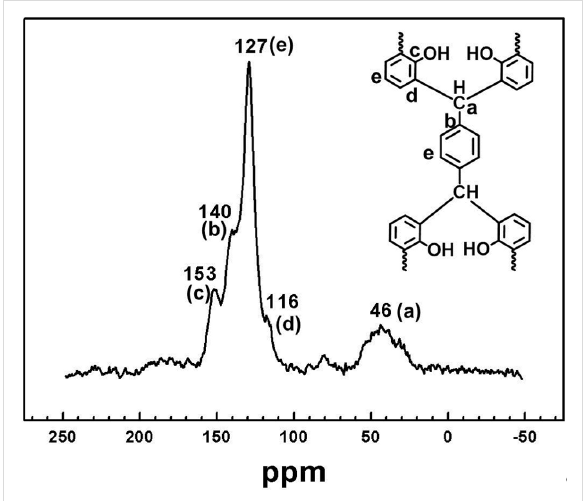
Figure 2: Solid-state 13 C CP/MAS NMR spectrum of PPOP-1 recorded at the MAS rate of 5 kHz.